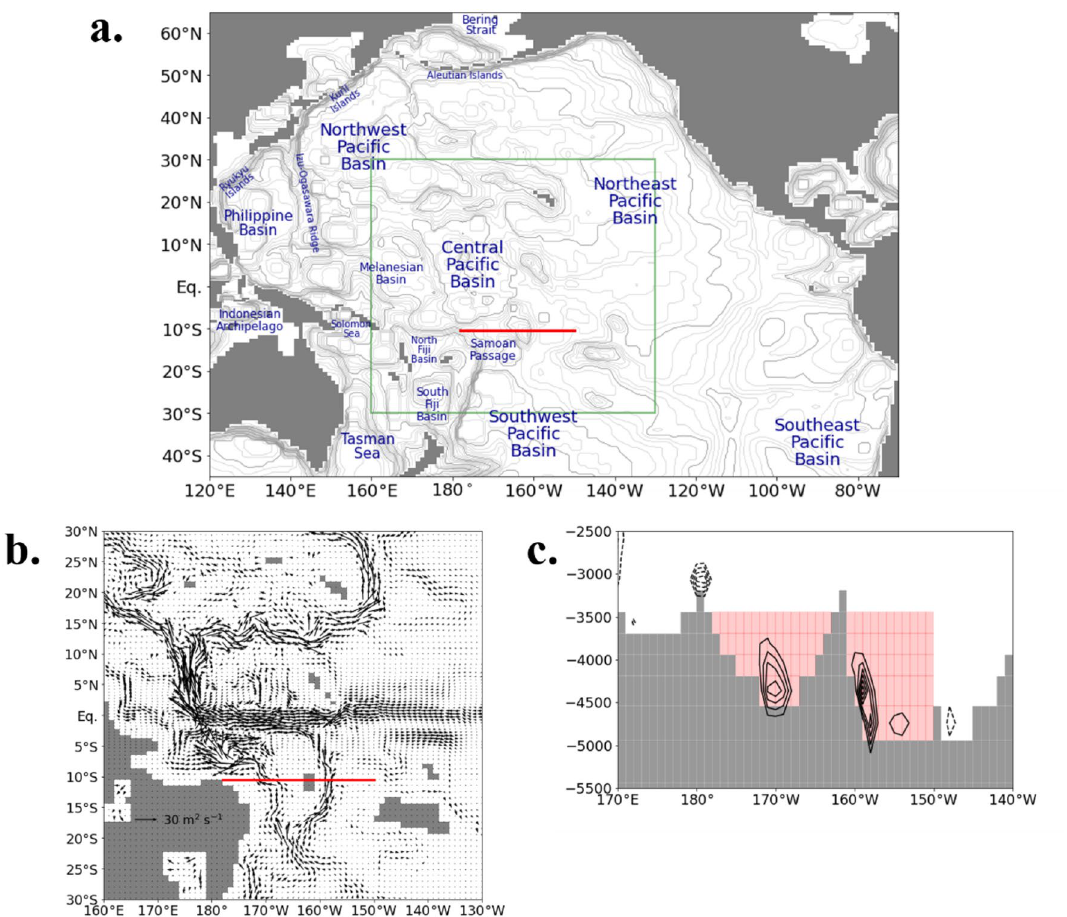
Figure 7. ( a ) Vertically integrated annual-mean horizontal velocity below 3500 m depth. ( b ) Annual-mean meridional velocity along 10°S. The contour interval is 0.005 m s -1 (zero line is not drawn). The solid and dotted lines show the northward and southward transport, respectively. The red line and pink shade indicate the section where the Lagrangian particles are